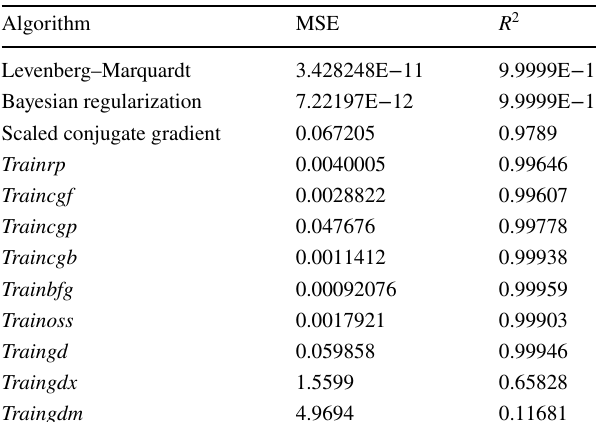
Fig. 8 Mean squared error (ANN) for iron(II) removal